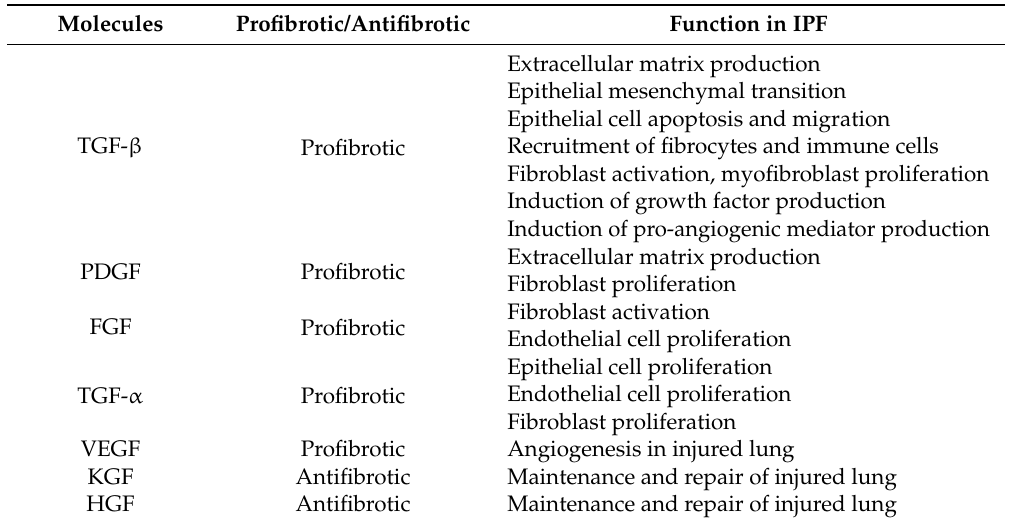
Table 1. Functions of representative molecules contributing to idiopathic pulmonary